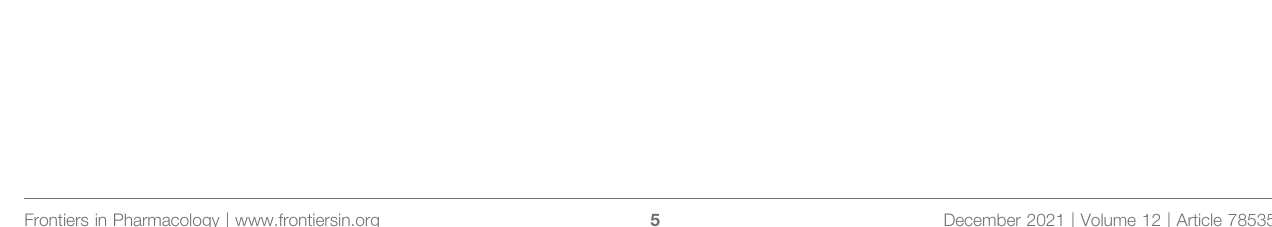
Frontiers in Pharmacology |